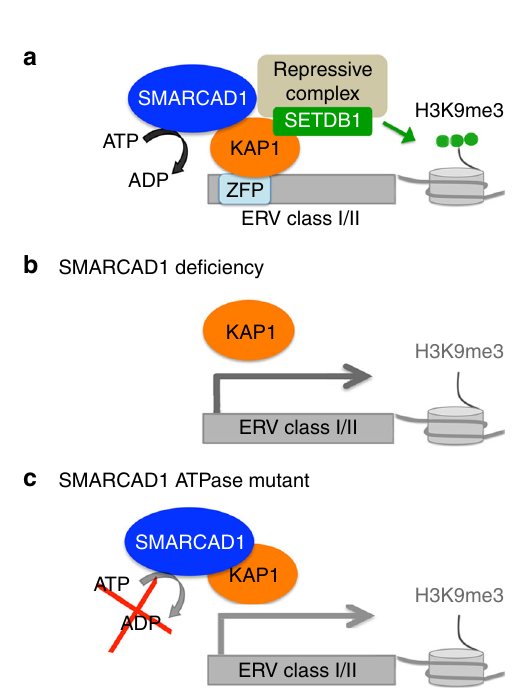
Fig. 7 Model; SMARCAD1 function in the KAP1-SETDB1 ERV silencing pathway. a ERVs recruit DNA binding zinc fi nger proteins (ZFP),